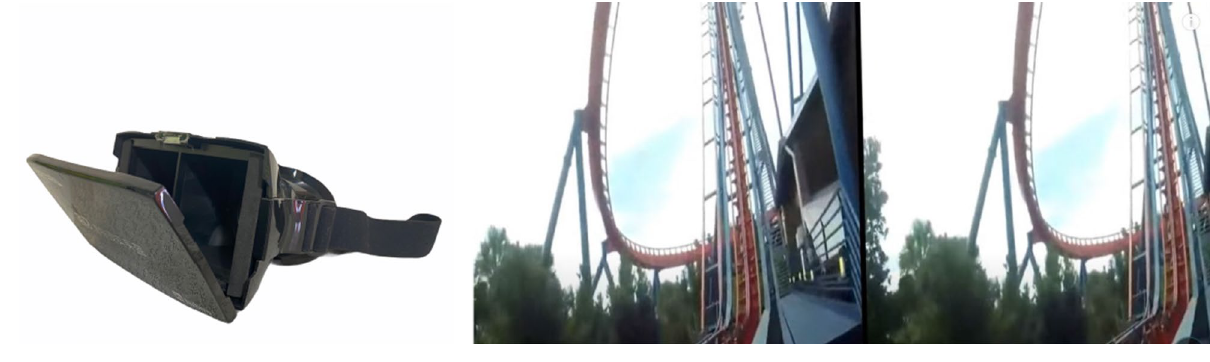
Table 2 list the results of the NHV examination. BI and BO represent the divergence and convergence abilities of both eyes, respectively. Figures 5 and 6 show variations in the NHV in the left and right eyes of the participants before and after using VR glasses, and the differences were not significant ( P > 0.05). However, the center values of the result revealed that the NHV for BI in both eyes decreased after using VR glasses compared with before using VR glasses. However, the NHV for BO in both eyes increased after using VR glasses compared with before using VR